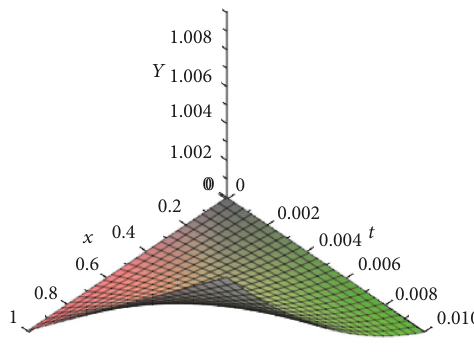
Figure 5: Numerical solution for (33) using VIMB when n=m=2 and 𝑡 = 0.01 .